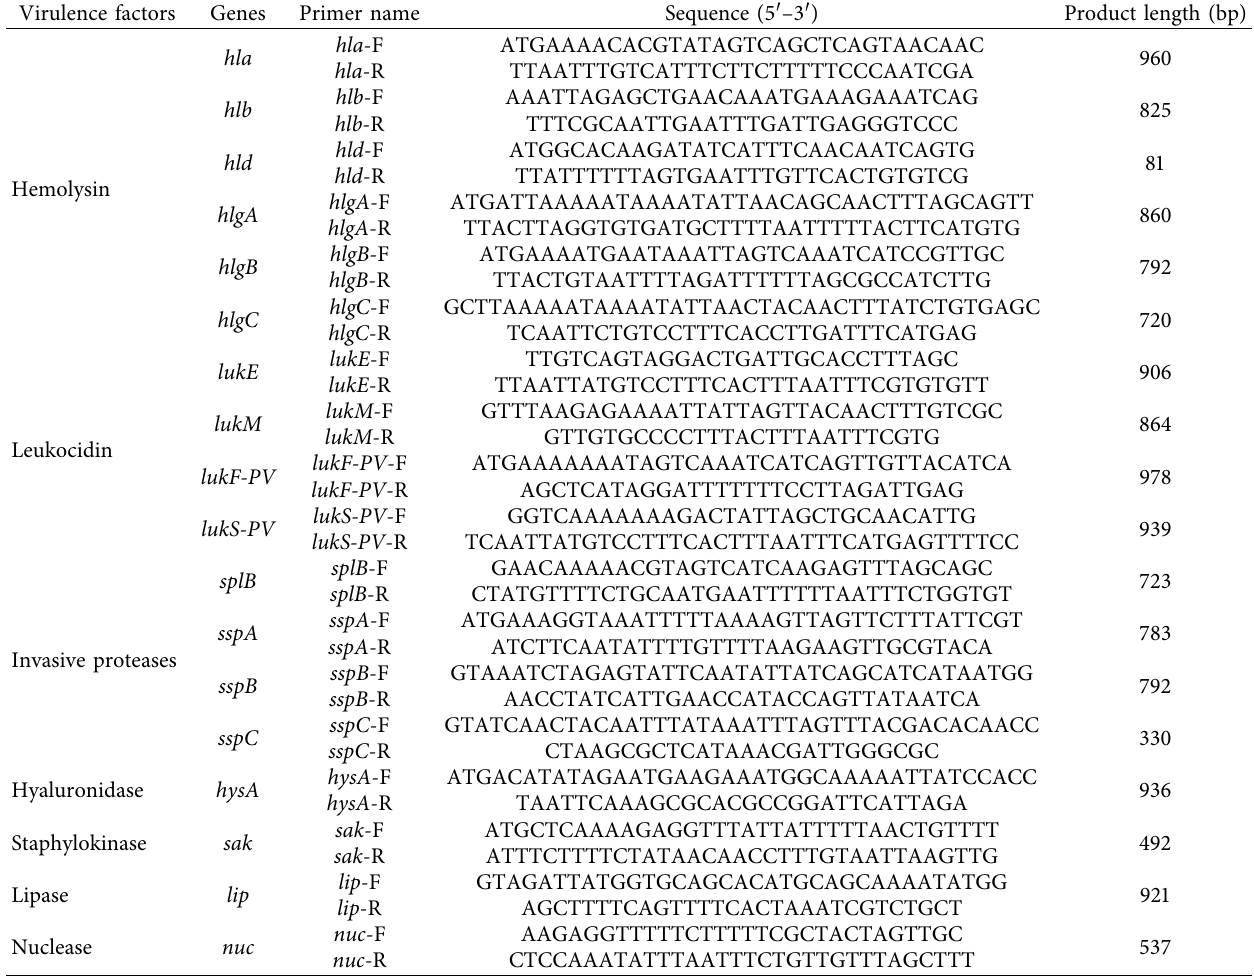
Table 1: Virulence factors, genes, primer sequences, and product